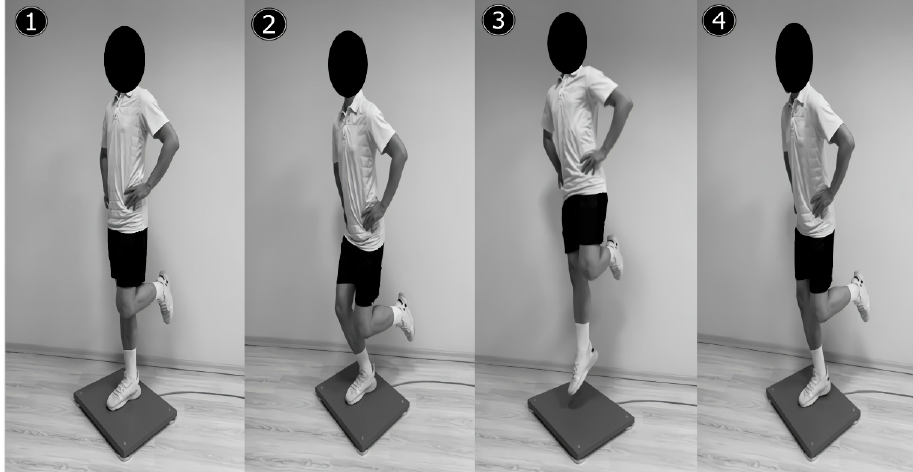
Figure 1. Phases of a single ‐ leg countermovement jump on a force plate. 1) Standing (quiet), 2) braking, 3) take ‐ off (flight), and 4)